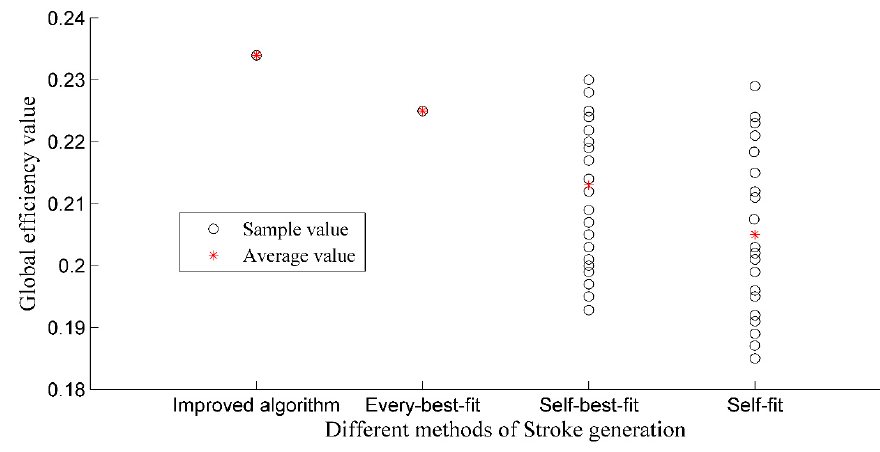
Figure 11. Global efficiency based on different stroke generation methods.